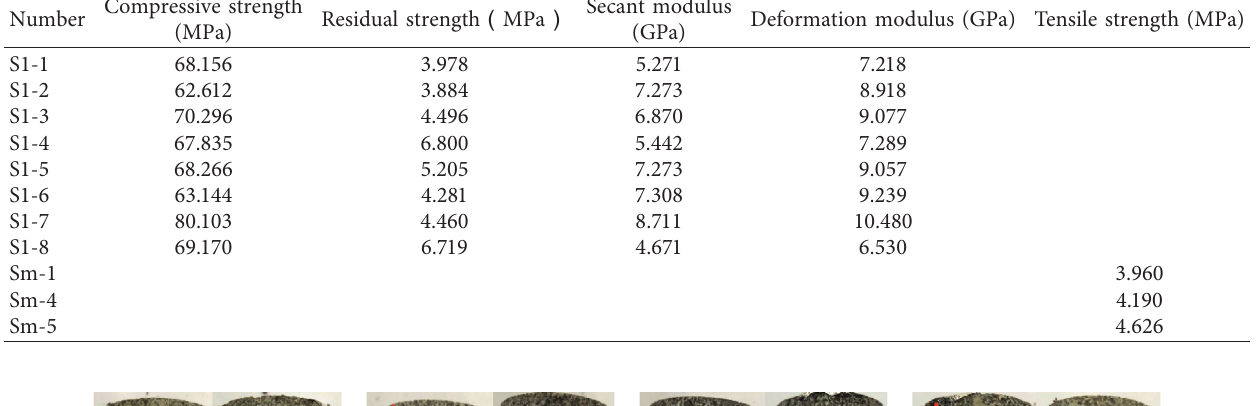
Table 3: Mechanical parameters of deep sandstone